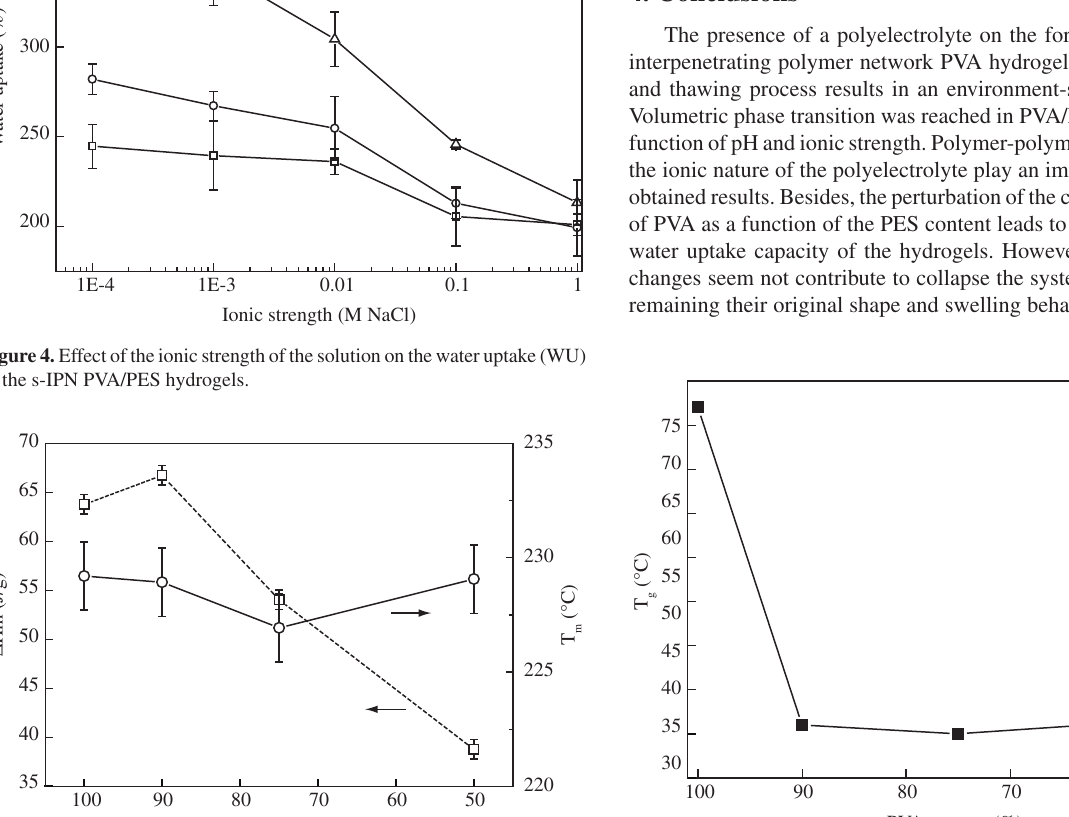
and ∆ H of the s-IPN PVA/PES m m